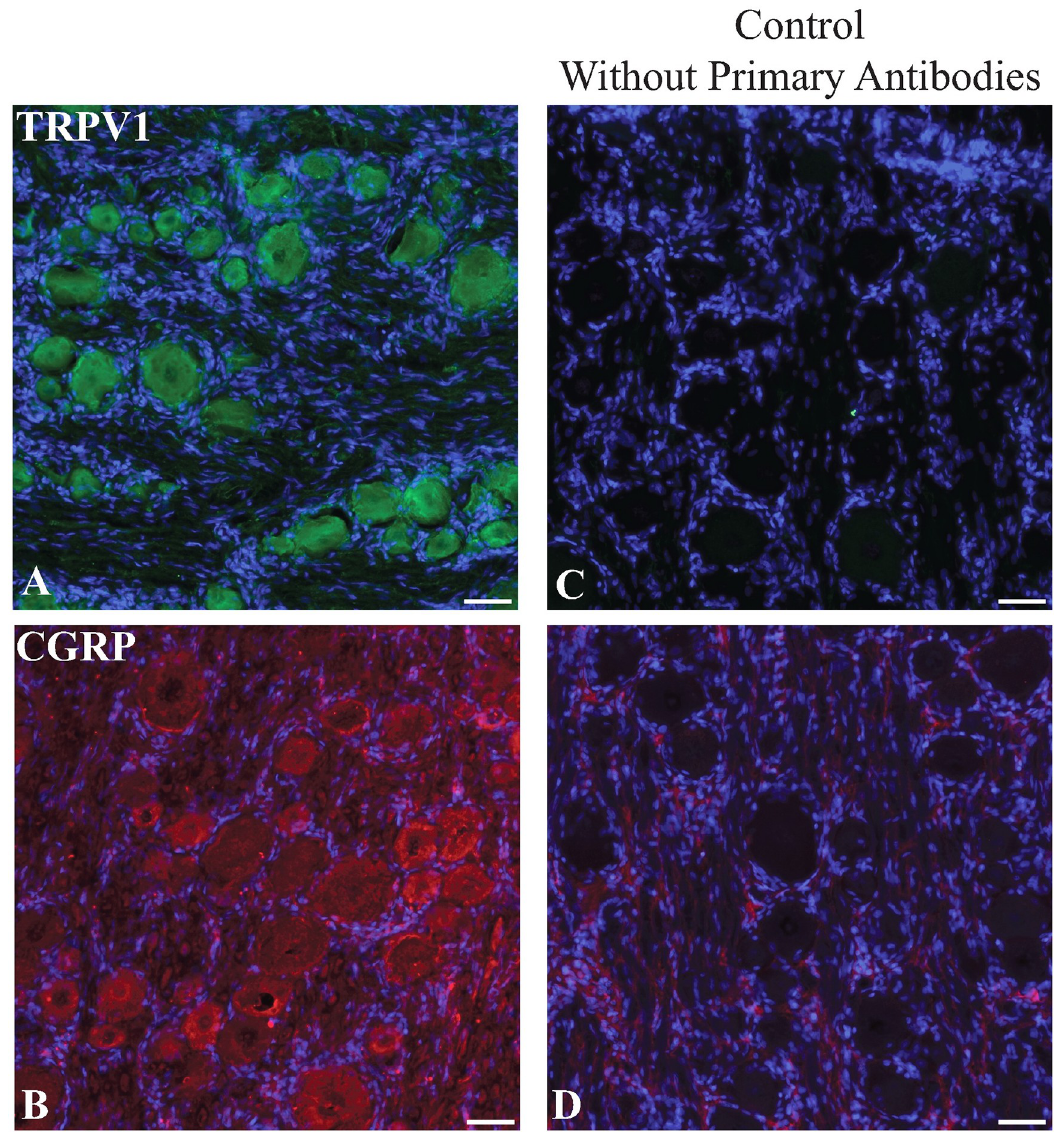
Fig 5. Immunolabeling miniswine DRGs. A-B: Miniswine DRGs were immunostained with commercial antibodies against TRPV1 and CGRP. C-D: Negative controls omitting primary antibodies. Nuclei were counterstained with DAPI. Scale bars: 50 μ m.